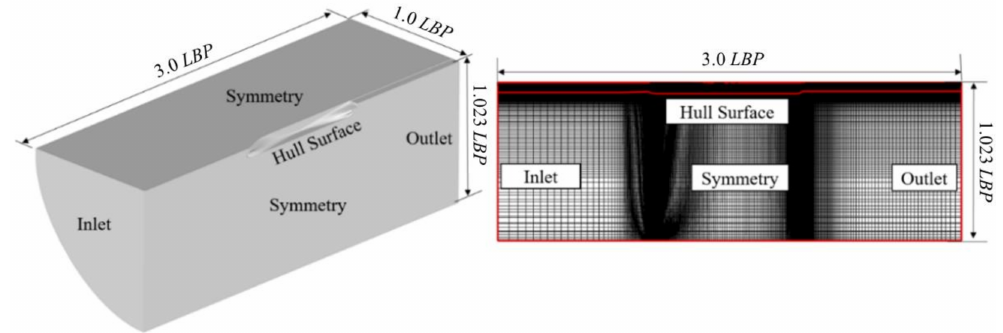
Figure 4. Computational domain and boundary conditions.